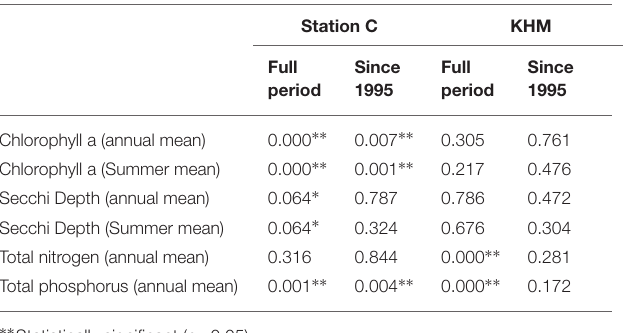
TABLE 3 | P -values of the long-term decreasing trend for water quality parameters observed at Station C (Large Lagoon) and KHM (Small Lagoon) computed for either the whole time period (see Figure 4 ) or since 1995.